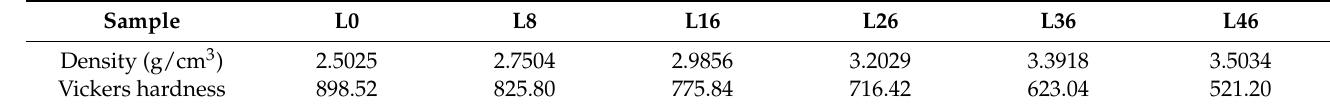
Table 3. Density and Vickers hardness of